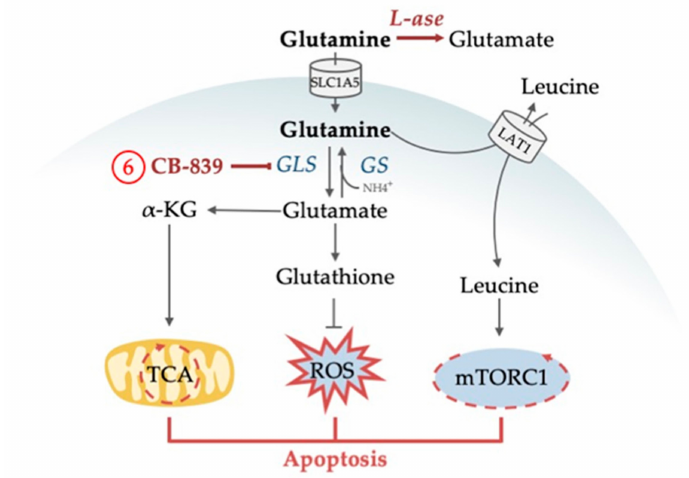
Figure 5. Drug targeting of glutamine metabolism in AML results in the inhibition of central cellular mechanisms followed by apoptosis. CB-839 inhibits glutaminase preventing the utilization of glutamine in TCA cycle replenishment and the production of ROS-eliminating glutathione. L-asparaginase has glutaminase activity and degrades extracellular glutamine. As a result, intracellular glutamine levels are not e ffi cient for leucine uptake and mTORC1 activation. Abbreviations: GLS, glutaminase; GS, glutamine synthetase; α -KG, α -ketoglutarate; L-ase, L-asparaginase; LAT1, large neutral amino acid transporter 1; mTORC1, mammalian target of rapamycin complex 1; NH 4 , ammonia; ROS,